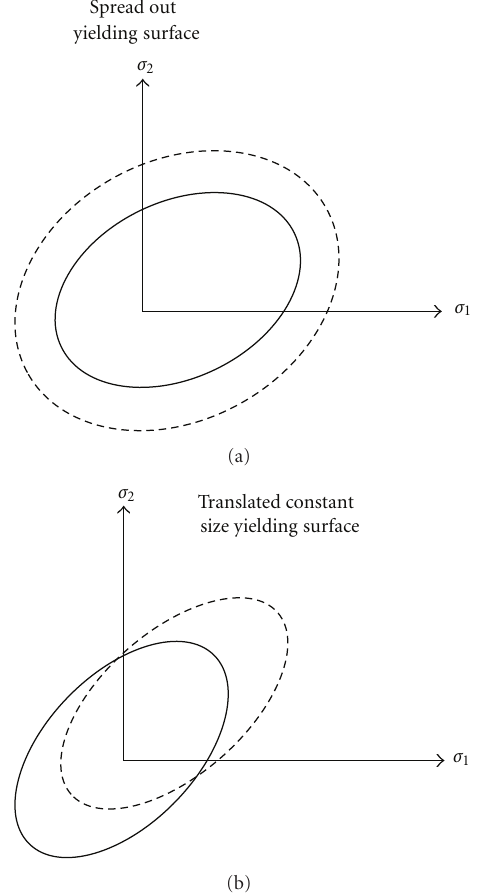
Figure 8: Isotropic (a) and kinematic (b) hardening models for two-dimensional stress field.